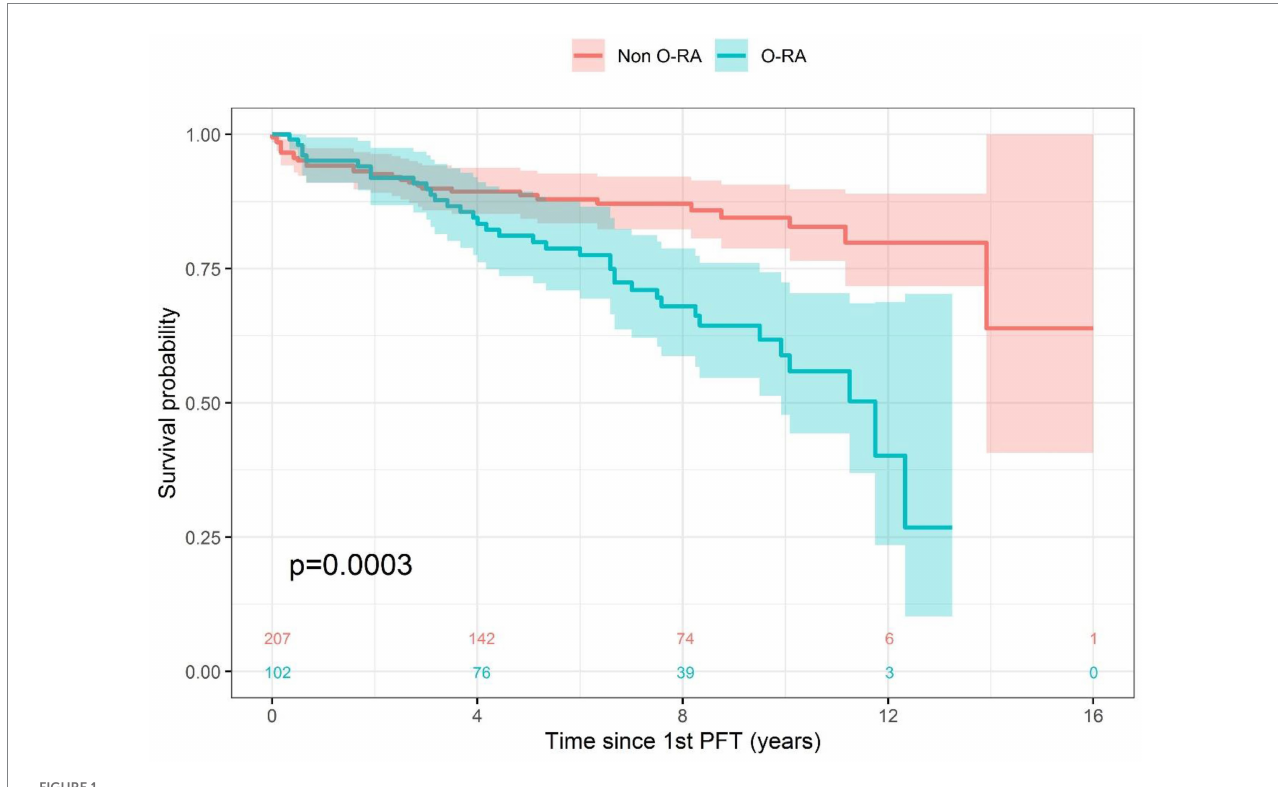
FIGURE 1 Survival